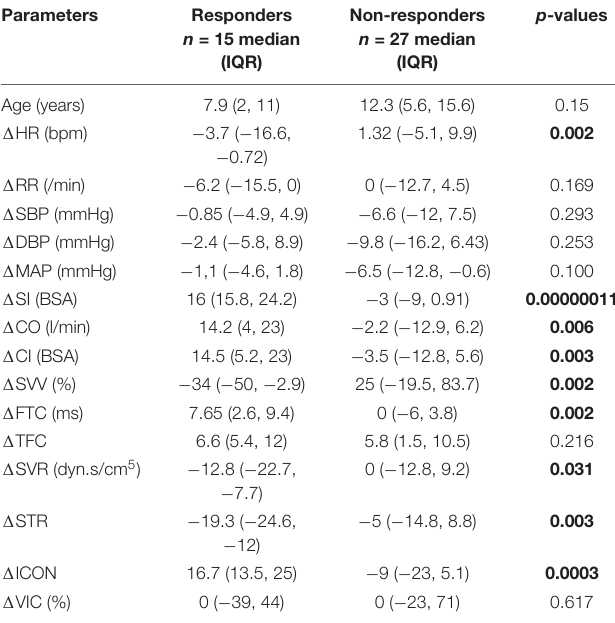
TABLE 3 | Changes in hemodynamic variables in responders vs. non-responders.